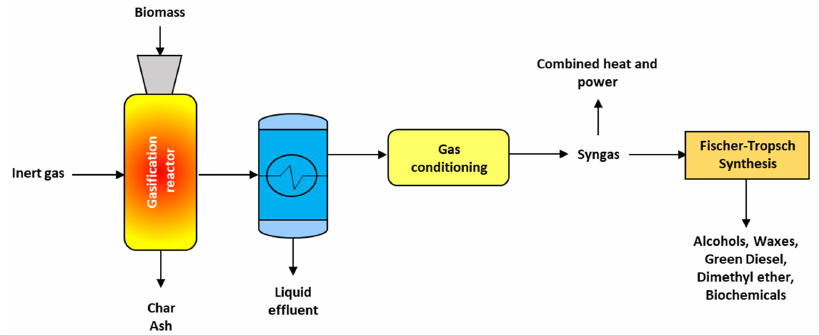
Figure 4. Typical process representation of gasification of biomass.